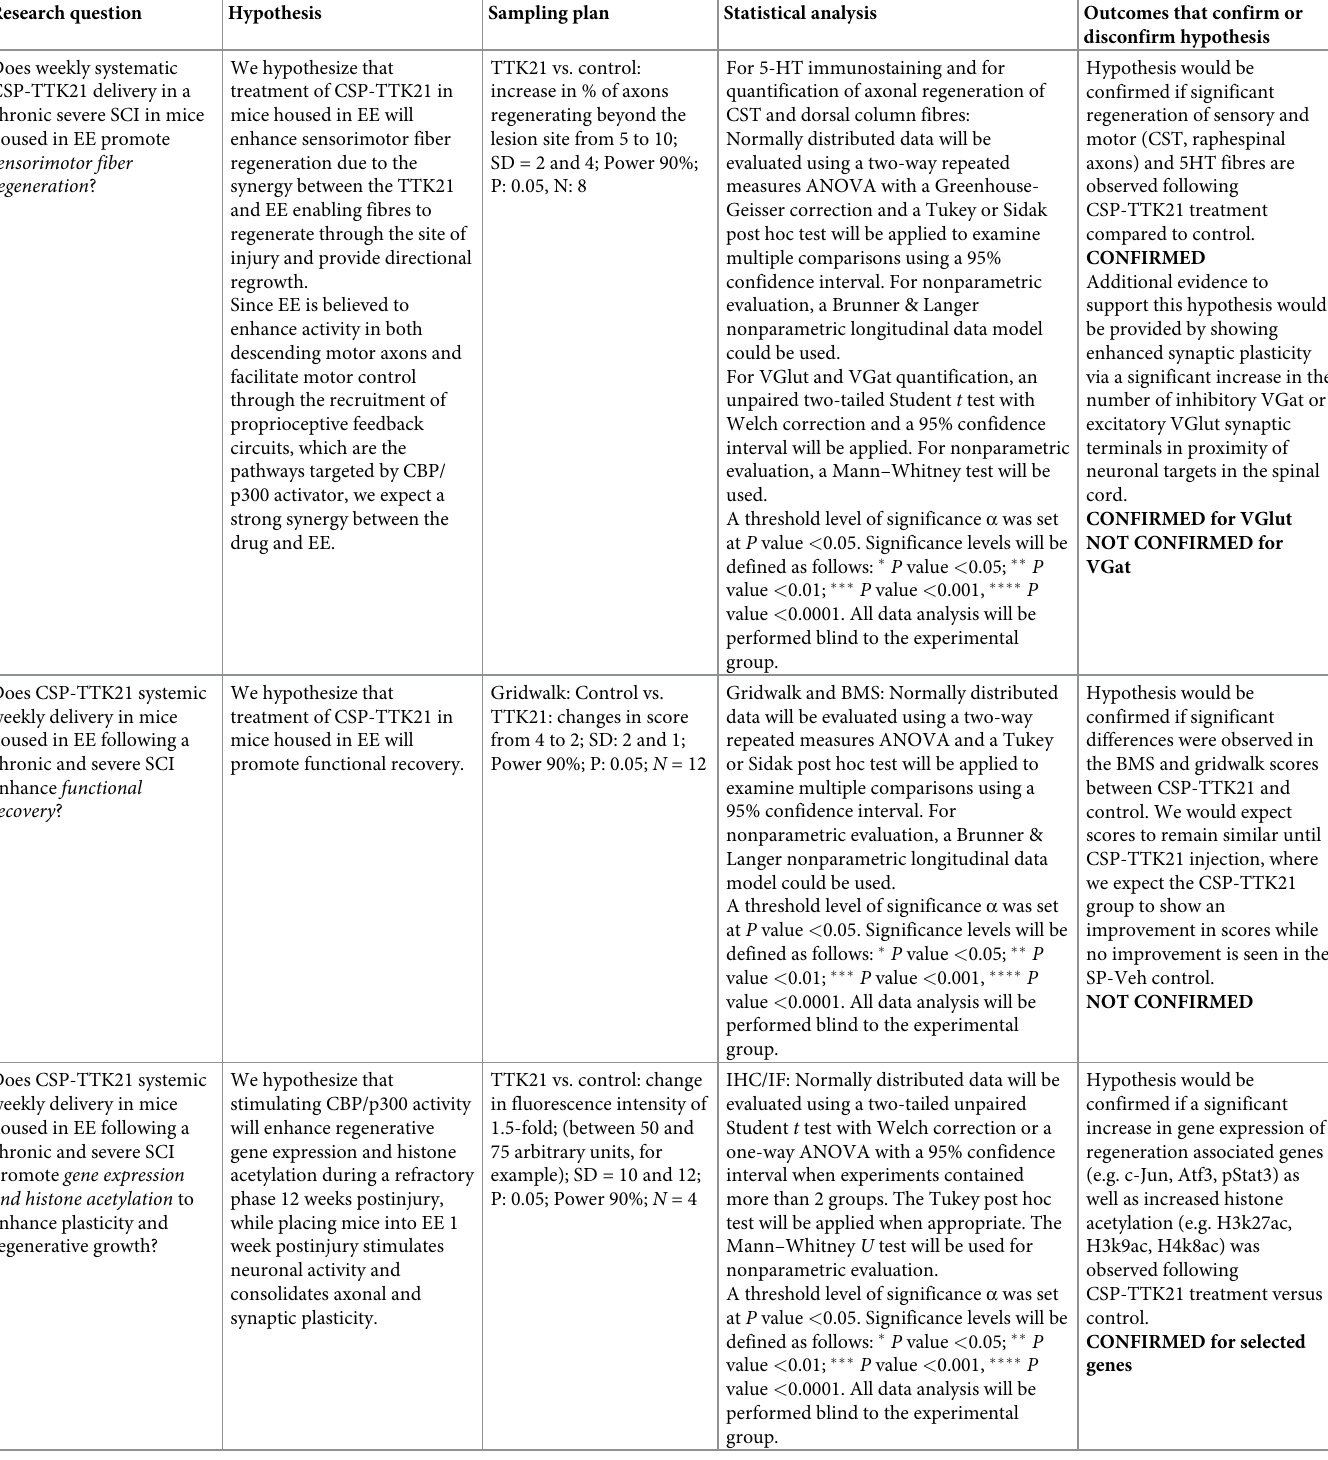
Table 1. Table summarizing the experimental design and data